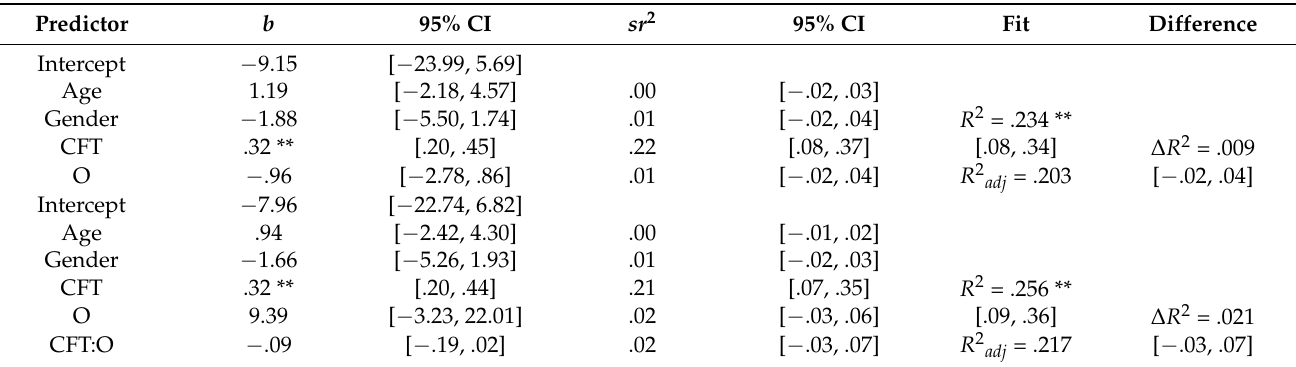
Table 5. Regressing mathematical abilities onto fluid intelligence and openness.